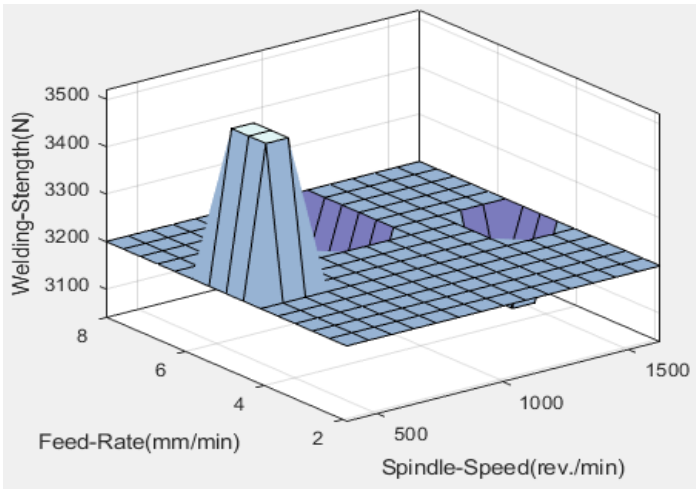
Table 14. Results of FSSW strength fuzzy system (dynamic